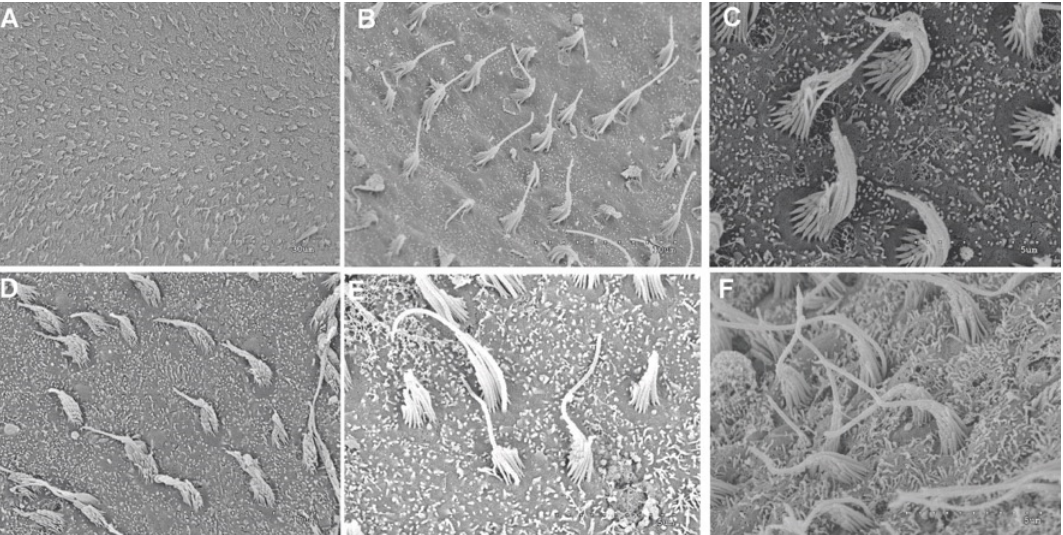
Figure 7. SEM (scanning electron microscopy). Utricle saccule sensory epithelium. ( A , B ) Exposed animals. Control. ( C – F ) By comparison with control animals, the images of the saccule epithelium show healthy sensory hair cells in all cases of exposed animals (1 week ( C ), 2 weeks ( D ), 3 weeks ( E ) and 4 weeks ( F ) of sound exposure). Scale bar: ( A ) = 30 µm. ( B , D ) = 10 µm. ( C , E , F ) = 5 µm.